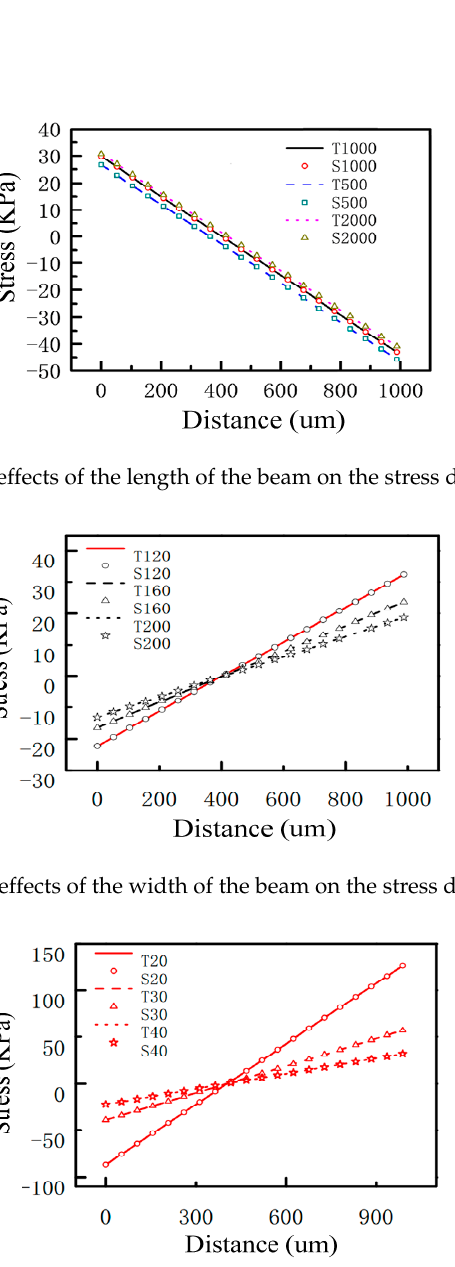
Figure 10. The effects of the thickness of the beam on the stress distribution.